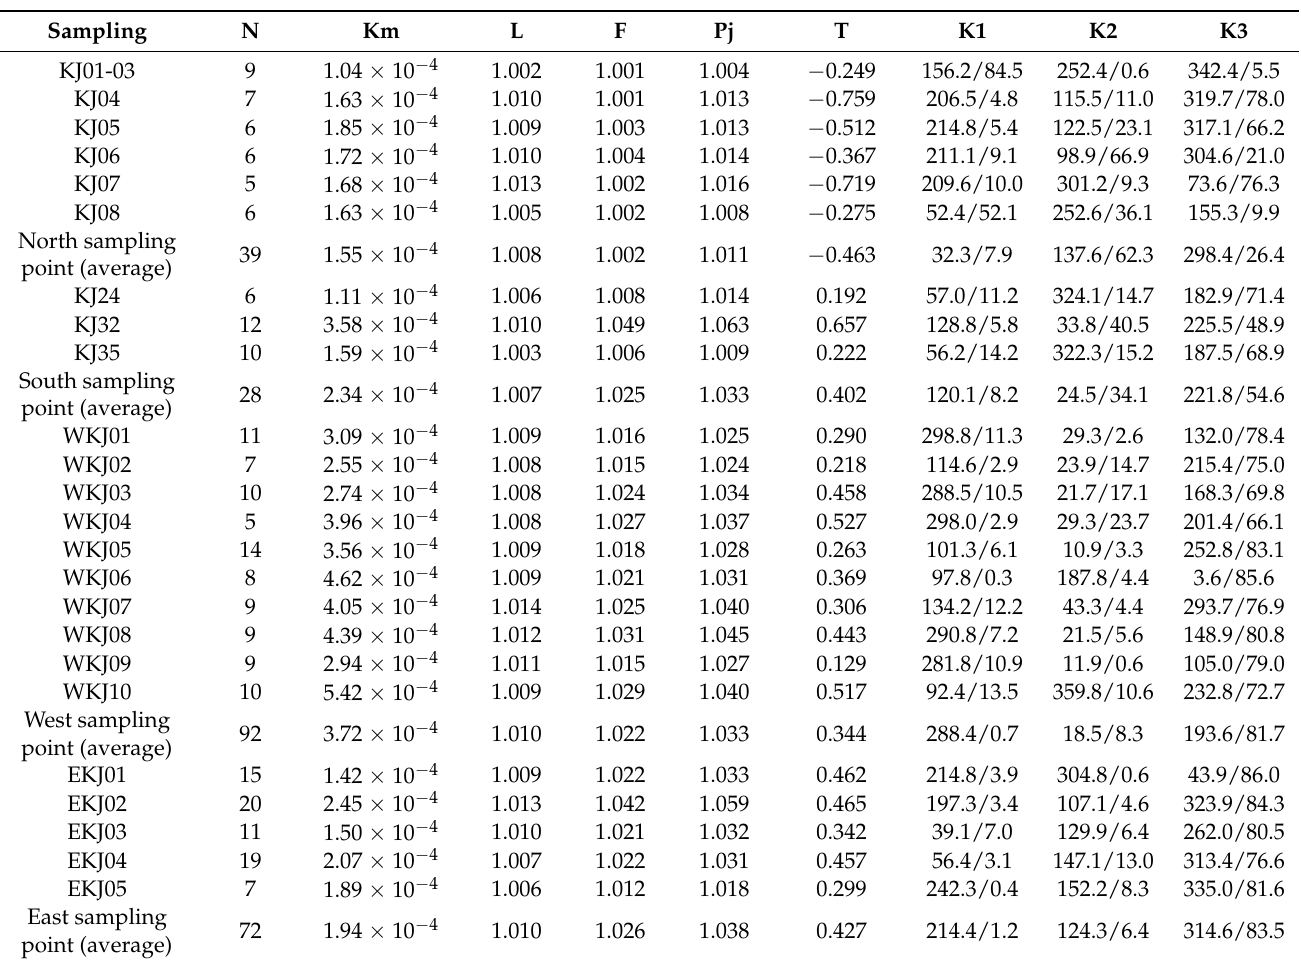
Table 1. Magnetic susceptibility parameters of the red-bed samples in the Jingzhushan Formation from the Nyima Basin in room temperature